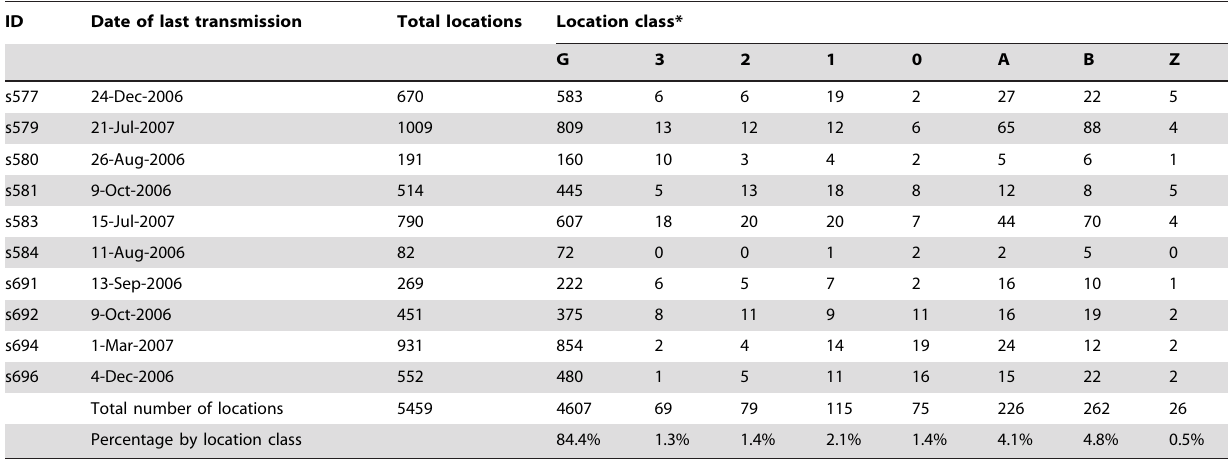
Table 1. Satellite transmitter performance summary.